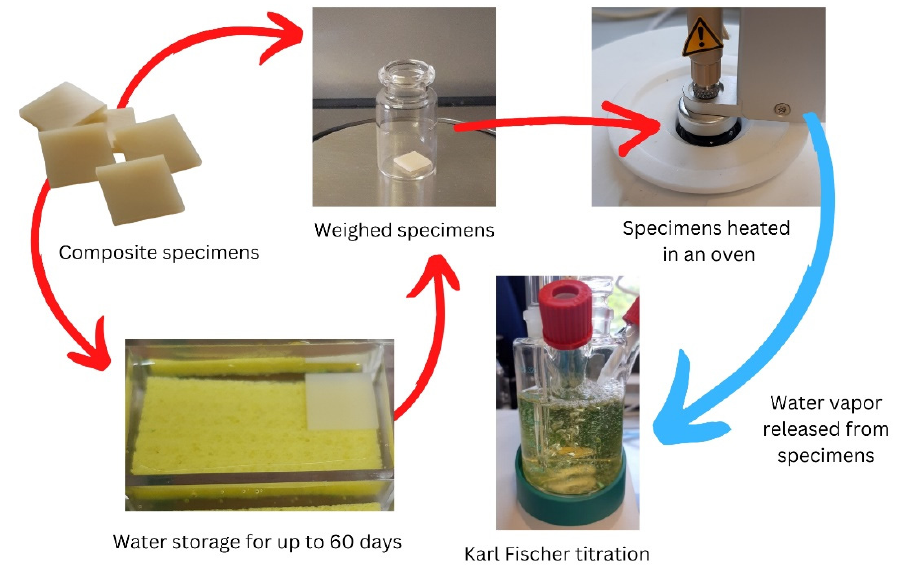
Figure 1. Diagram illustrating the experimental set-up. Water content data were analyzed by 2-way Analysis of Variance (ANOVA). Pair-wise comparisons were performed using Tukey’s test. The significance level was set at 95% for all